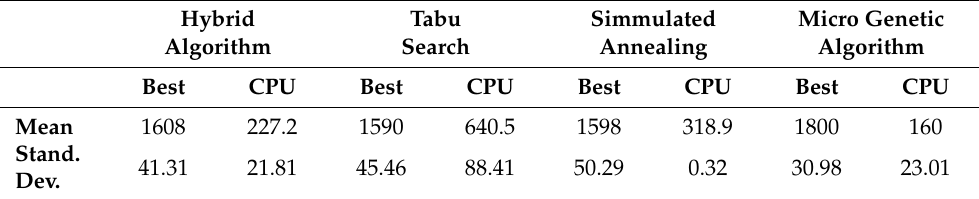
Table 7. Comparison of mean and standard deviation values with a feasible solution as an initial solution. Hybrid Tabu Simmulated Micro Genetic Algorithm Search Algorithm